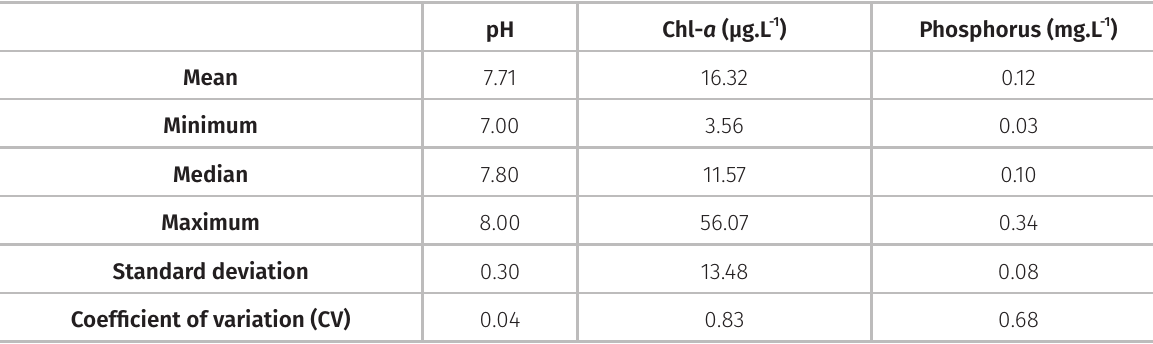
Table II. Descriptive statistics of the data obtained in the